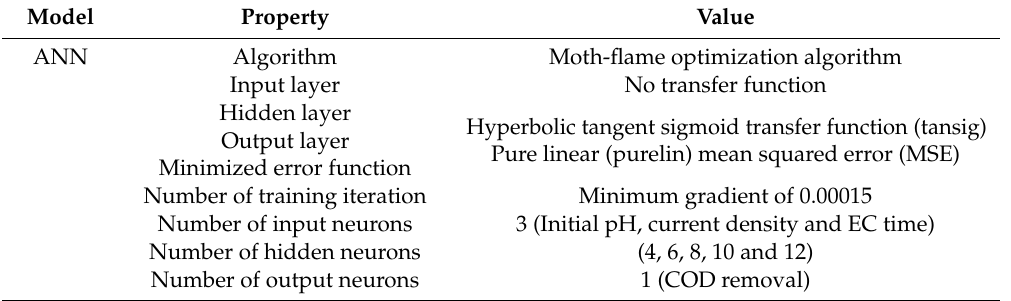
Table 2. ANN modeling for cold meat industry wastewater EC treatment.